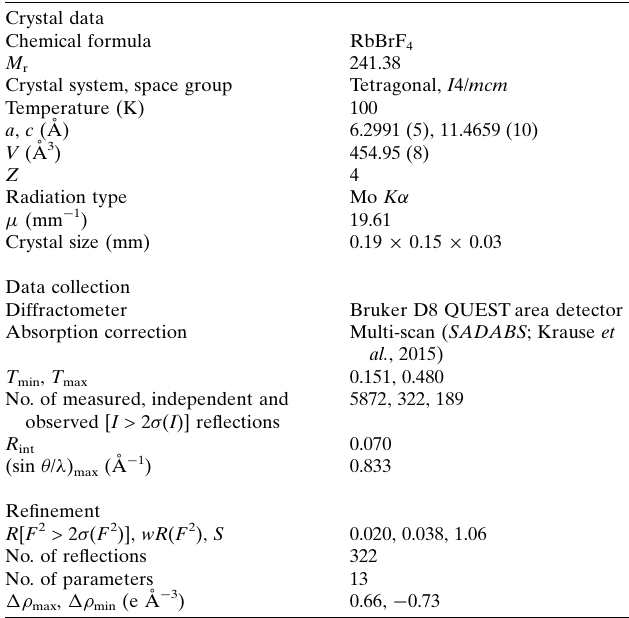
Table 1 Experimental details.